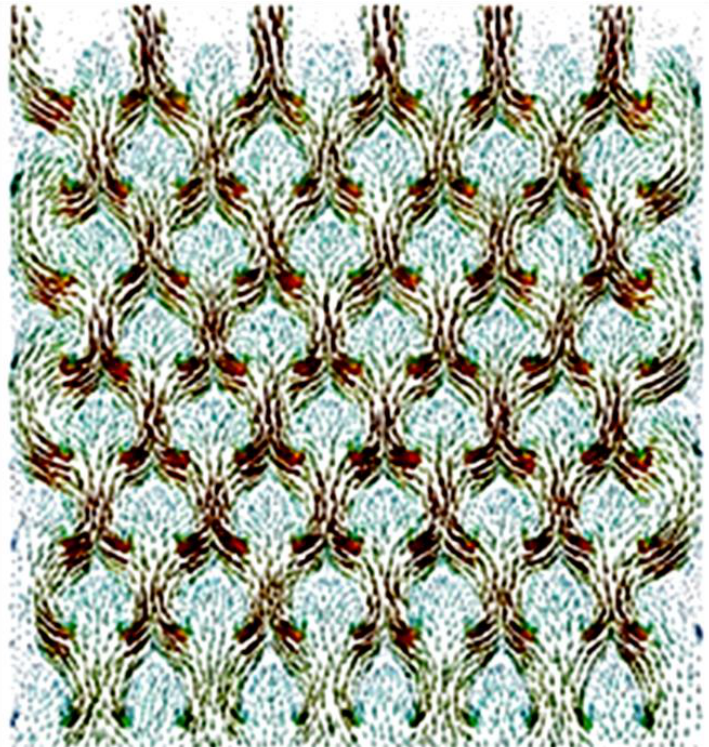
Figure 6. The wave-like structure of the gas flow inside a separator with arc-shaped elements. The vector field of velocities was recorded for the midplane perpendicular to the separator inlet.